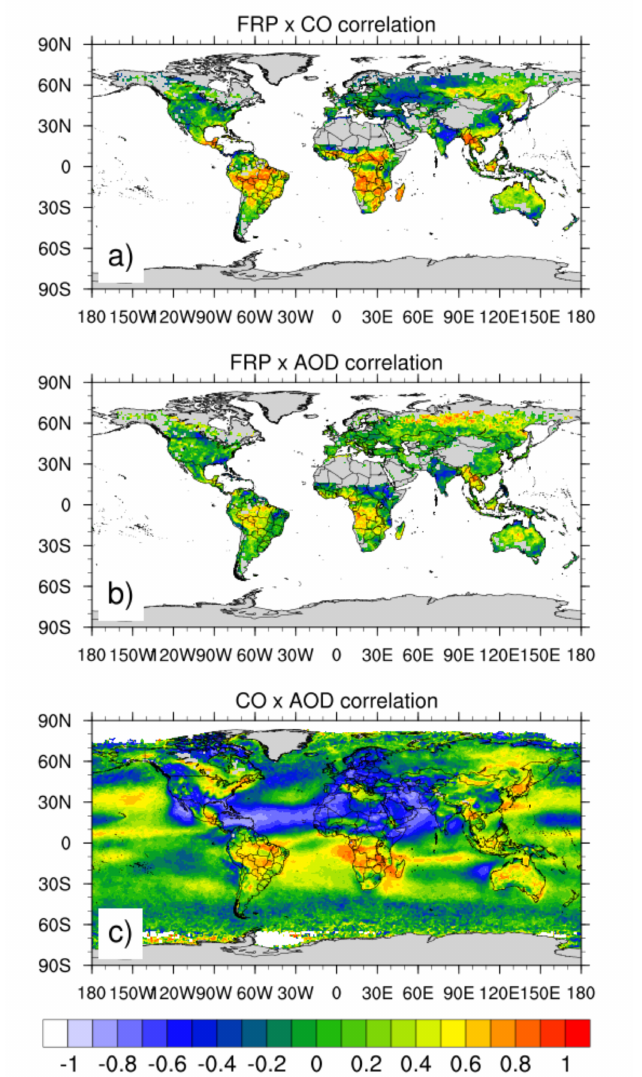
Figure 14. ( a ) Correlation coefficient between FRP (MW) MODIS and CO (ppb) from MOPITT, showing the highest prevalence of both parameters over the agricultural regions such as southeast Asia and southern China. ( b ) Correlation coefficient between FRP (MW) with AOD from MODIS, showing a positive correlation over less dense regions such as forested and agricultural lands across the globe. ( c ) Correlation coefficient of CO from MOPITT (ppb) with AOD from MODIS, showing different trends compared to correlations between FRP and CO and FRP and AOD ( a , b ). The AOD prevalence is higher in the tropical and sub-tropical